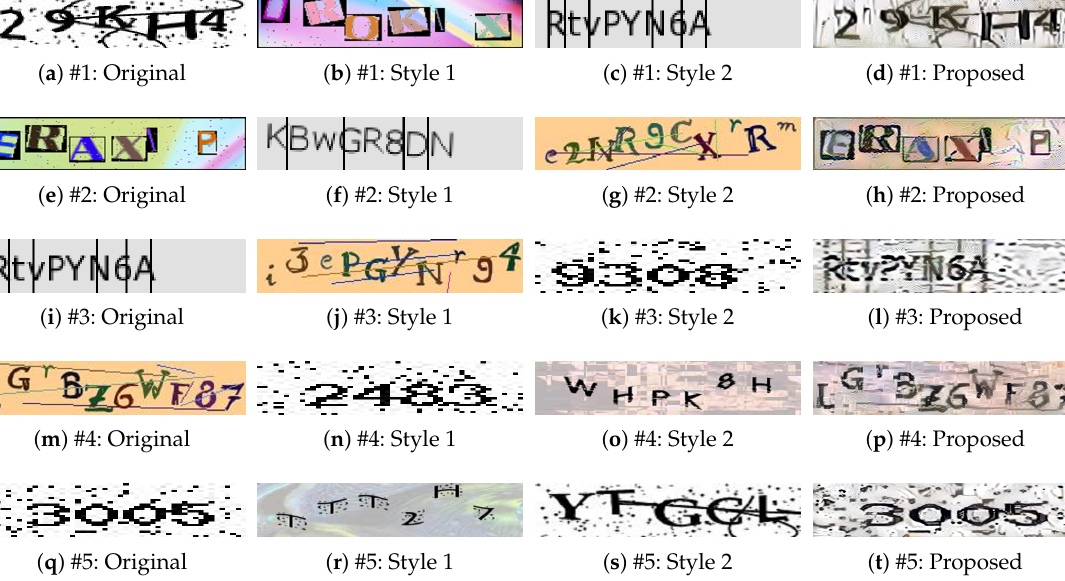
Figure 5. Examples of style-plugged CAPTCHAs formed using two style images. A set of images for each dataset is shown: “Original" is the original image, “Style 1" is style image 1, “Style 2" is style image 2, and “Proposed" is the style-plugged-CAPTCHA